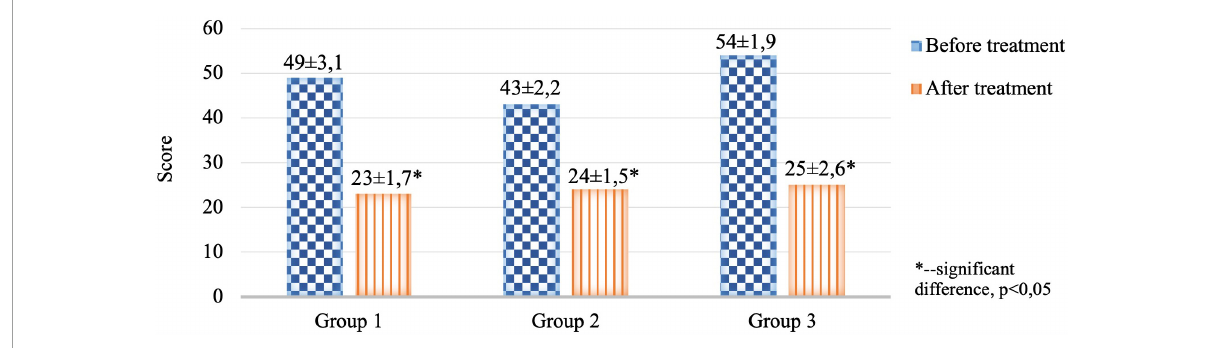
Before treatment